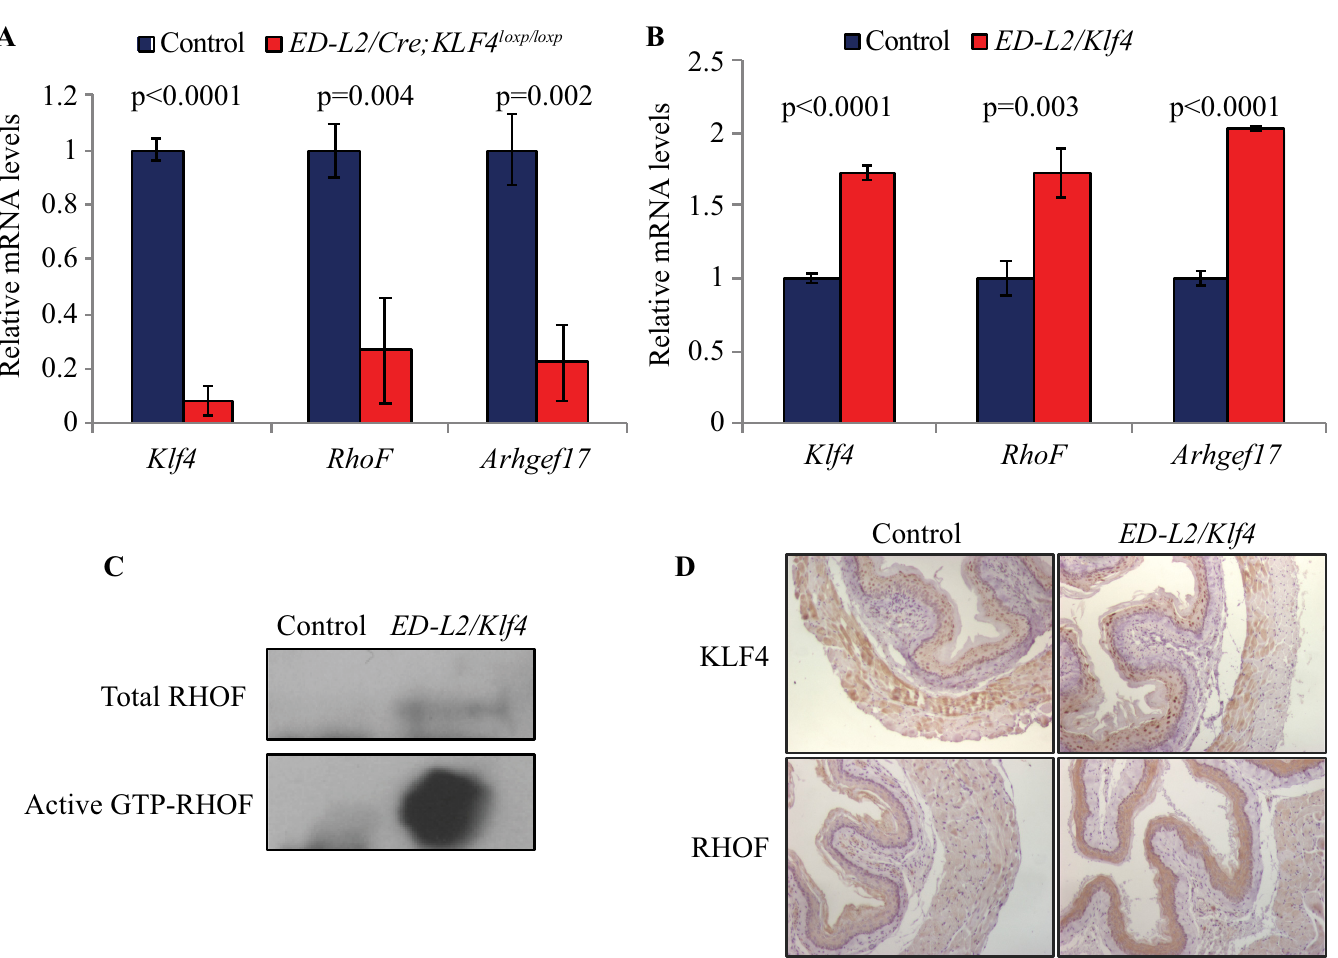
Fig 2. KLF4 increases RhoF expression and activity in esophageal epithelial cells. ( A ) By qPCR, Klf4 , RhoF , and the guanine-exchange factor Arhgef17 were significantly decreased in esophageal epithelial cells from mice with Klf4 deletion, compared to cells from control mice. ( B ) When Klf4 was increased in esophageal epithelial cells from mice with Klf4 overexpression, RhoF and Arhgef17 were increased on qPCR, compared to control cells. ( C ) Esophageal epithelial cells from mice with Klf4 overexpression also demonstrated an increase in the amount of activated RHOF, indicated on a RHOF activation assay. ( D ) Staining for RHOF (brown) was low in esophageal epithelia of control mice and increased markedly in mice with Klf4 overexpression. Magnification =